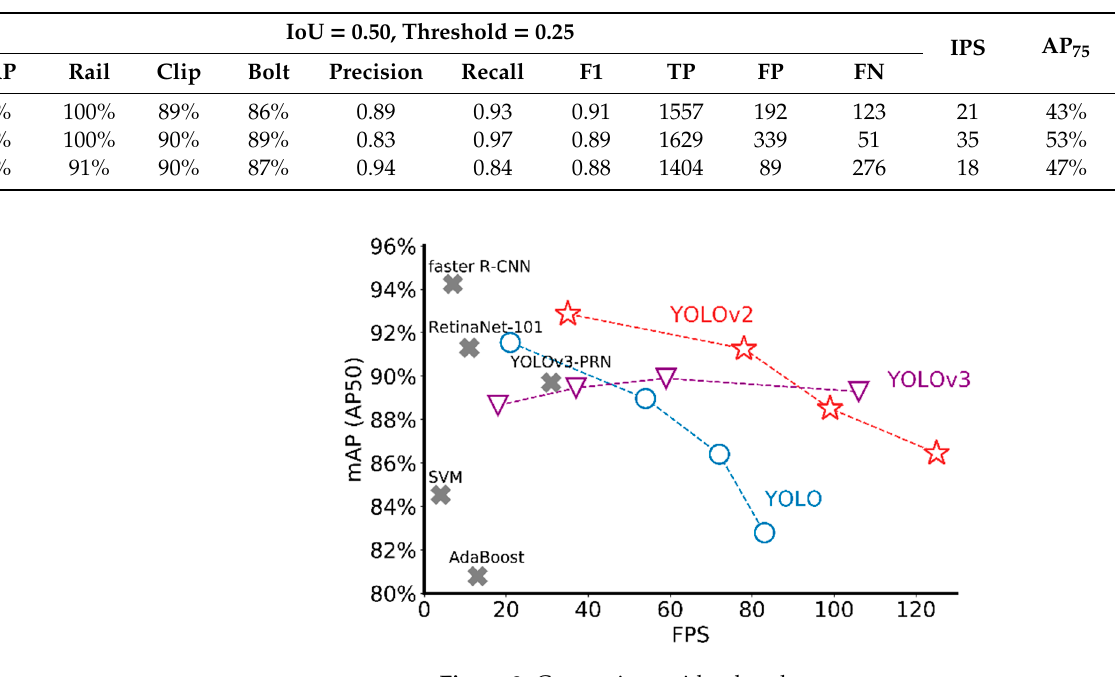
Figure 8. Comparison with other detectors.